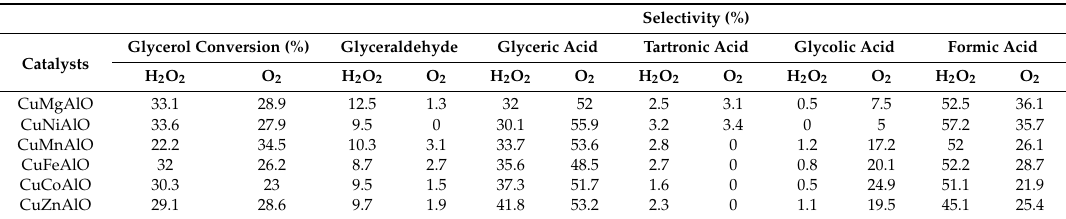
Table 1. Obtained results for the oxidation of glycerol, using two different oxidants, in Zhang et al.’s work a,b [52].